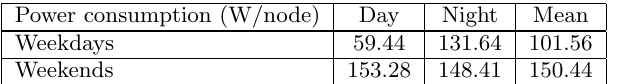
Table 1: Consumption trends on Grid’5000 from 2015-01-01 to 2015-02-19